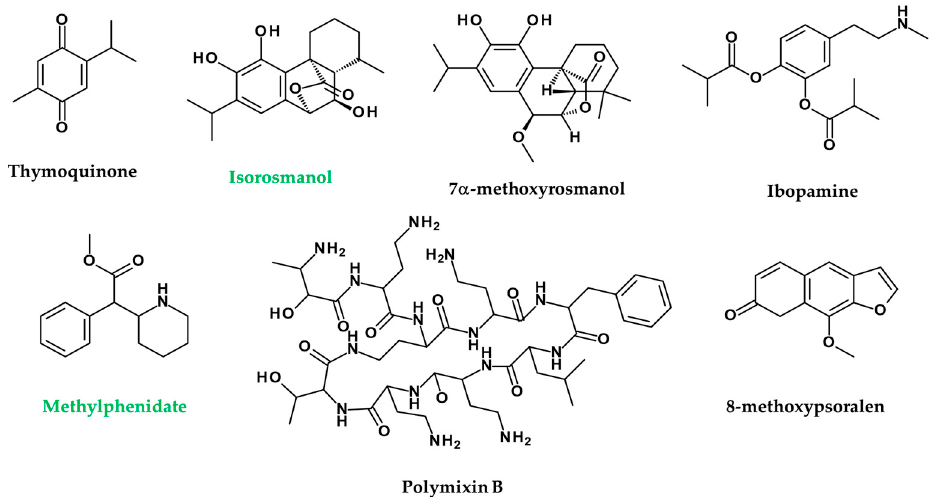
Figure 8. Chemical structures of compounds inducing (black) or inhibiting (green) melanogenesis. Seven phenolic diterpenes, namely, sageon, 12-methylcarnosol, carnosol, 7 β -methoxyrosmanol, 7 α -methoxyrosmanol, isorosmanol, and epirosmanol, are separated from the methanol extracts from the aerial portion of Salvia officinalis .